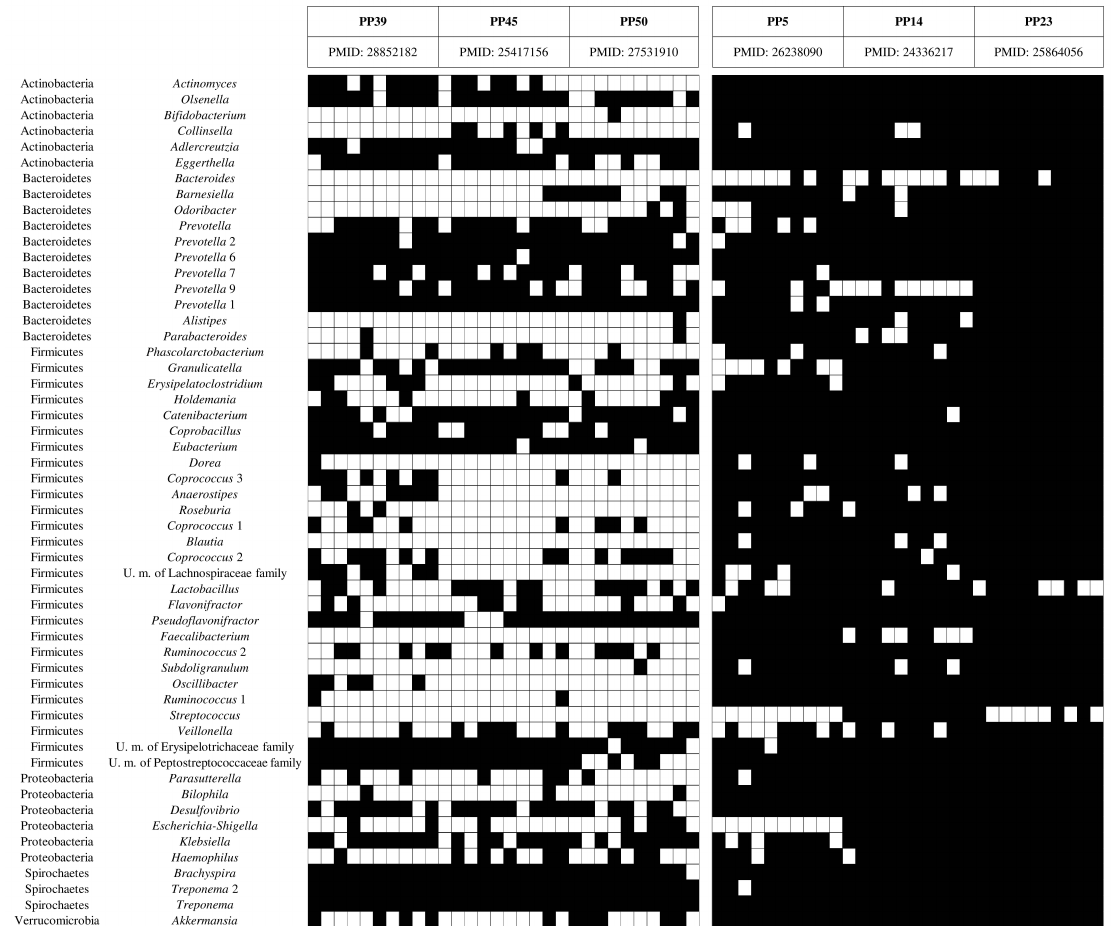
Figure 2. 16S rRNA gene-based microbial profiling analysis of human fecal samples. The heat map reports the deduced relative abundance of 54 bacterial taxa that are commonly found in the human gut microbiota. The black cell indicated the absence of the bacterial